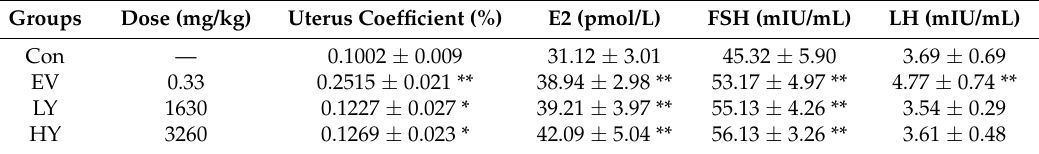
Table 2. Effect on uterus coefficient, estradiol (E2), follicle stimulating hormone (FSH), and luteinizing hormone (LH) (x ± SD, n =